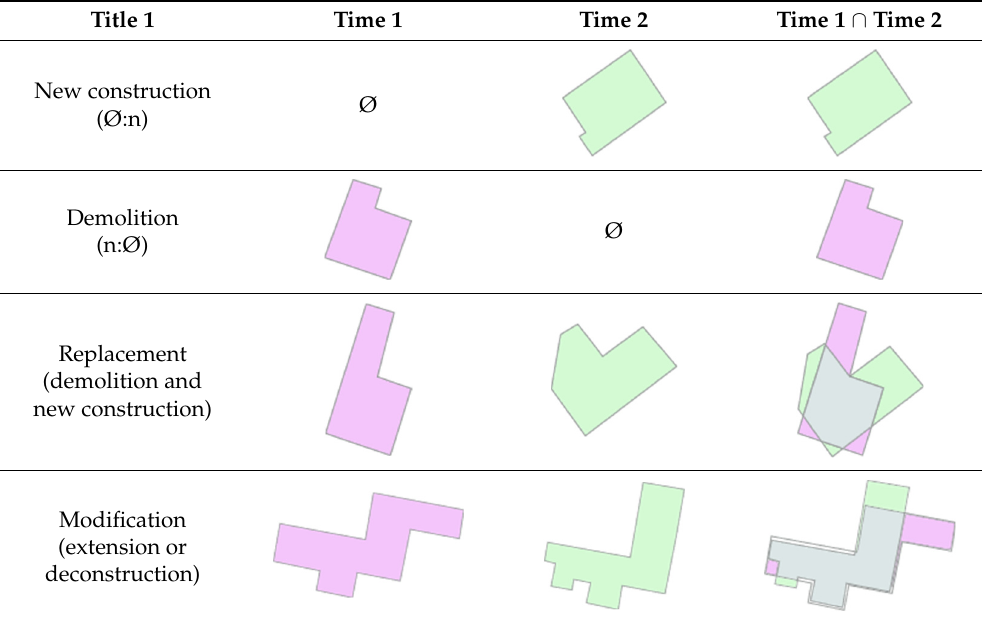
Table 1. Types of building changes.